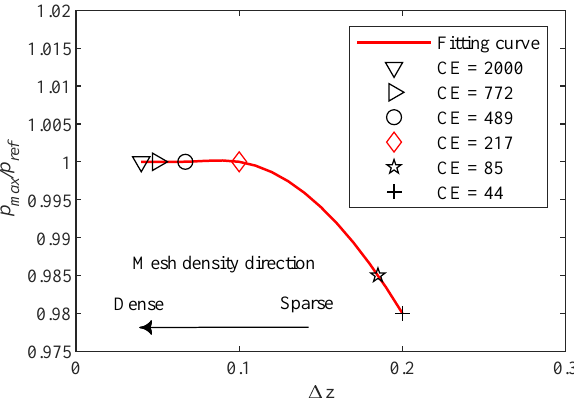
Figure 4. Mesh convergence in the z -direction.